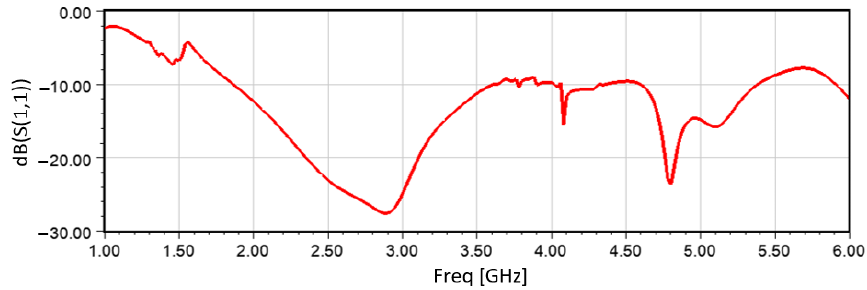
Figure 13. Reflection coefficient (S 11 ) of the proposed antenna 2.